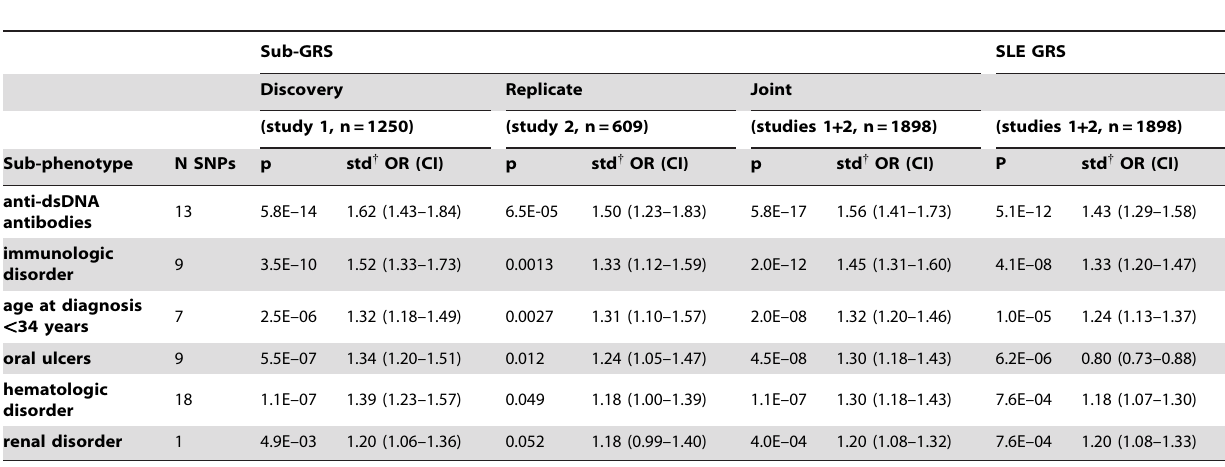
Table 4. Logistic regression results for sub-GRS and SLE GRS, for subphenotypes with sub-GRS p , 0.1 in replication set (study 2).